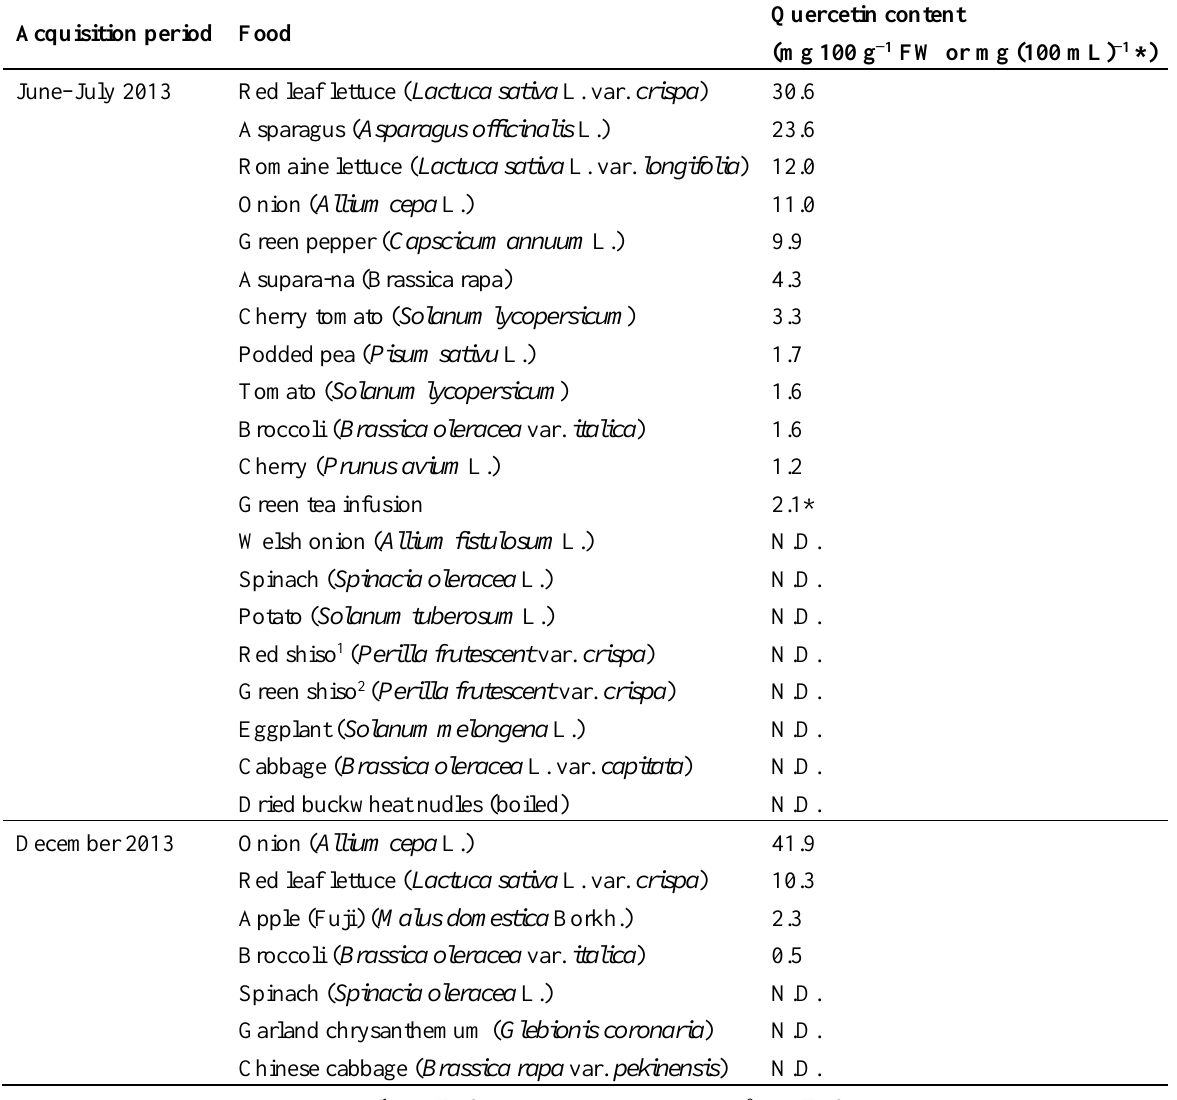
Table 1. Quercetin content in commonly-eaten foods in